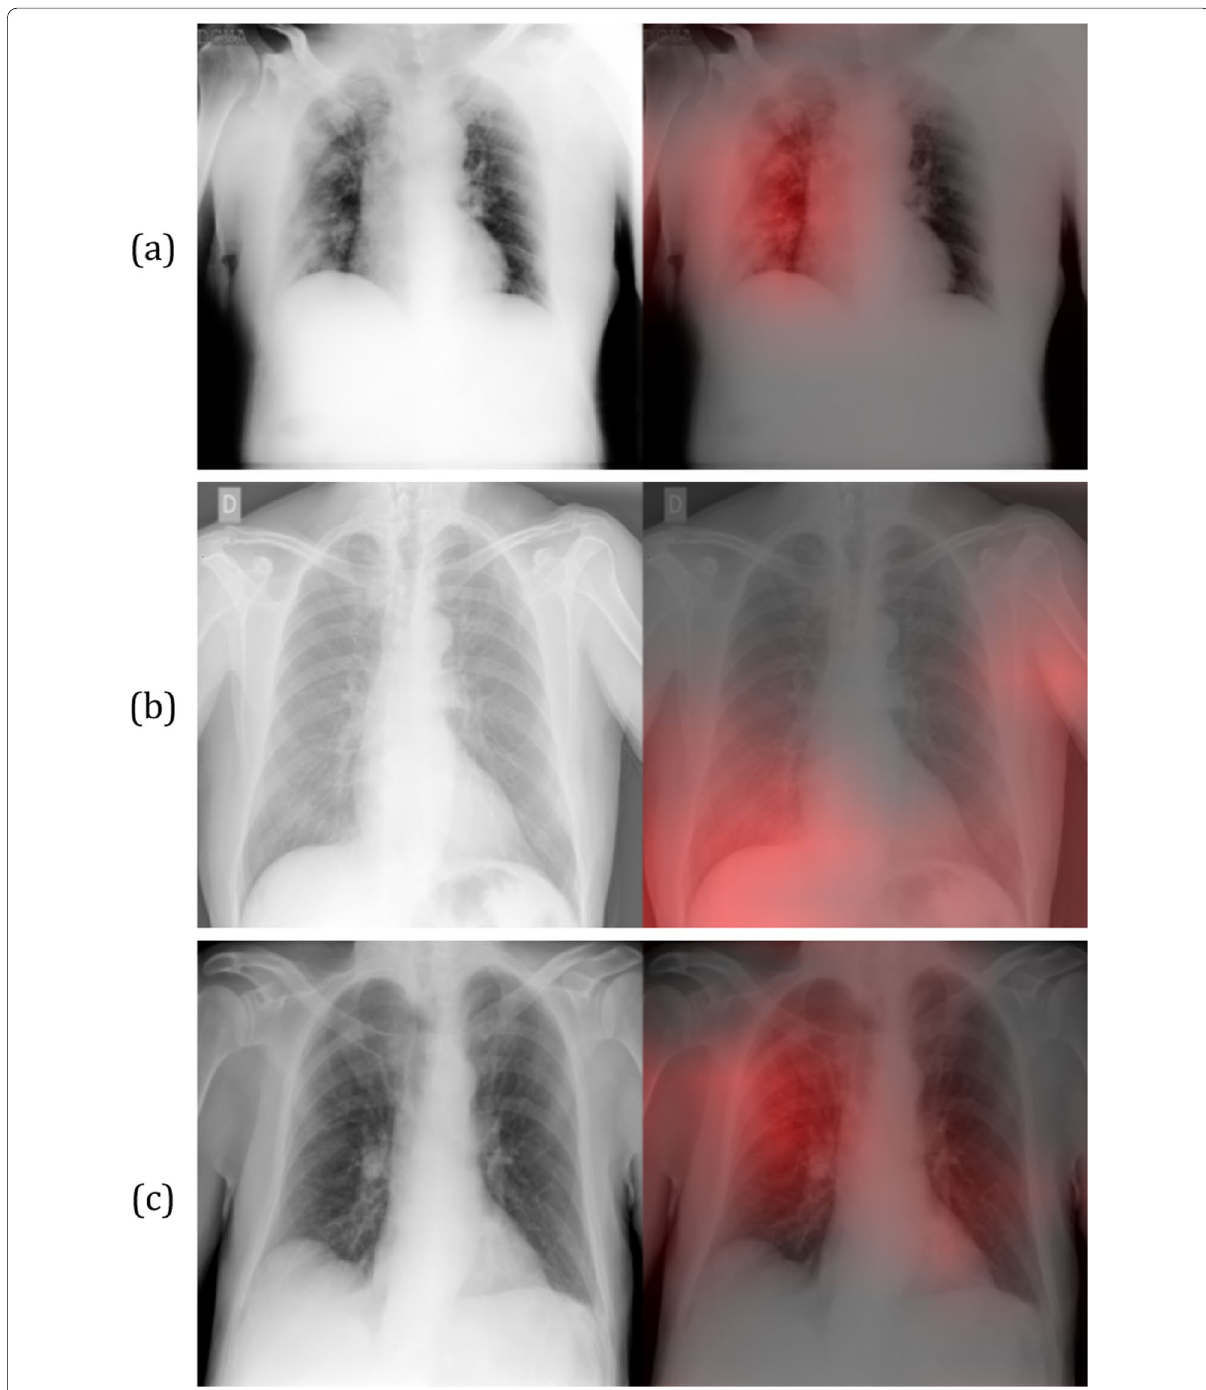
Fig. 3 Grad‑CAM heatmaps for False Positive COVID‑19 predictions. The red intensity of the images on the right indicates the important regions for a false positive prediction. These regions correspond to multiple consolidations with no zone predominance in the right lung ( a ), a unilateral right lower lung opacity and the contralateral soft tissues in the axillary region ( b ), superimposition of the scapula in the right lung periphery along with the left lower lobe vessels behind the heart ( c